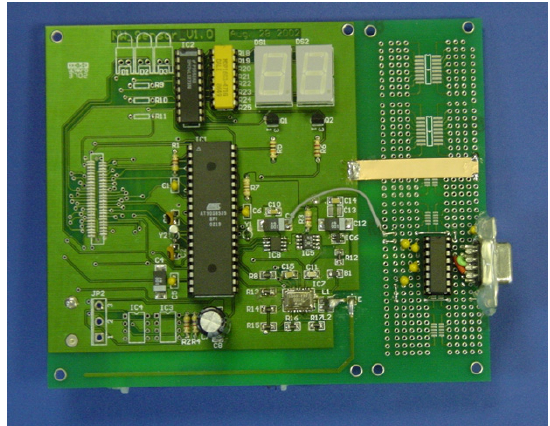
Figure 3c. The controller board of the host node; on right is the RS232 interface that transfers node information to the computer.